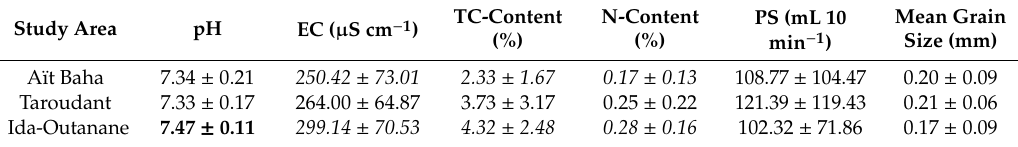
Table 4. Statistical summary of soil parameters pH, electric conductivity (EC), total carbon content (TC-content), nitrogen content (N-content), percolation stability (PS), and mean grain size for each study area (bold values show significant differences ( p < 0.05) between one study area compared to the other two; italic values show significant differences between two study areas).